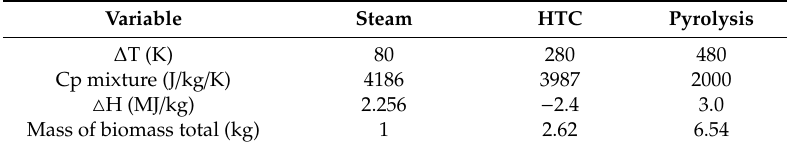
Table 7. Independent results from the second example energy demand